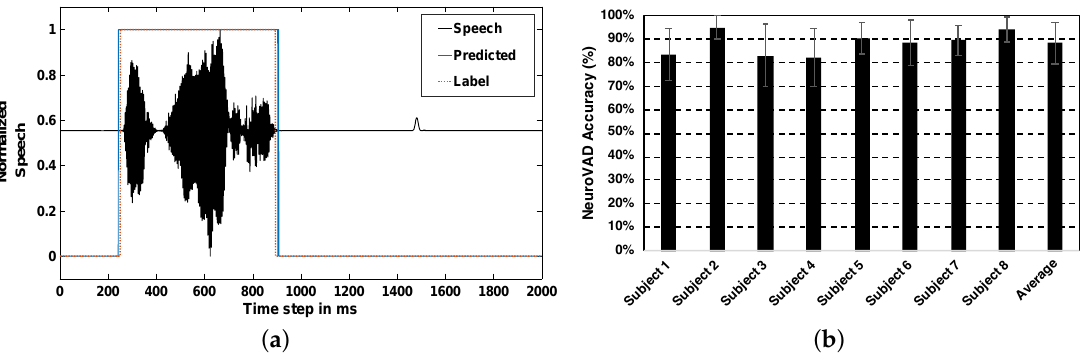
Figure 5. Prediction results with NeuroVAD: ( a ) while subject 8 was speaking “That’s perfect” and ( b ) Prediction accuracy with LSTM-RNN for all 8 subjects and their average; Error bars indicate the standard deviation in predictions across